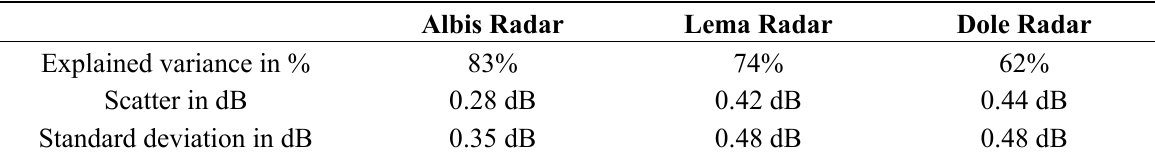
Figure 2. Daily variability of the Sun’s emission retrieved from the MeteoSwiss weather radars in Lema, Dole and Albis. The values from DRAO (20 UTC) are plotted for reference purposes. Table 2. Agreement between the Swiss radar horizontal channel and the DRAO reference (20